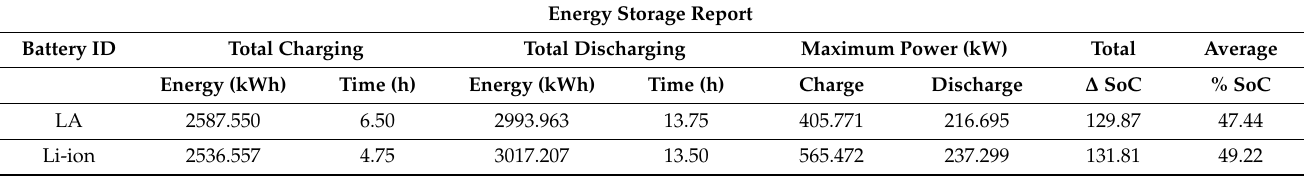
Table 6. Energy storage analysis